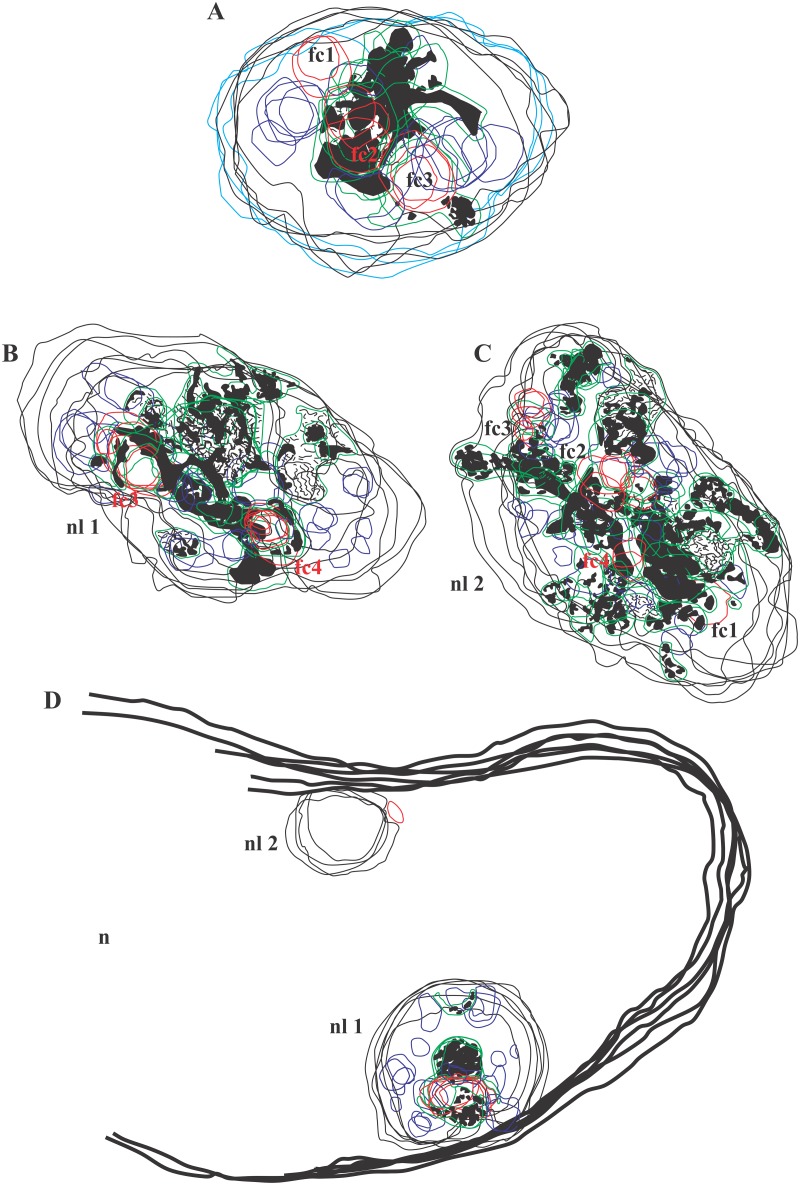
CLEM approach: Step 4.Within cells treated with AMD during 1 h, the contours of nucleolar components identified on serial ultrathin sections were superposed to build 3D models of four different nucleoli (nl). Confocal images of the same nucleoli were used to confirm the identification of ICC (GFP fluorescence) and of FC (UBF fluorescence). The color-code is: nuclear and nucleolar contours—black and light blue lines; FCs—red and brown lines; ICC—black shading; NVs—green lines; DFC—dark blue lines. (A) 3D reconstruction of the equatorial part of the nucleolus in cell N°1(serial ultrathin sections on S10 Fig and serial fluorescent images shown on S14D and S14E Fig). (B, C) Two pre-segregated nucleoli in cell N°2 (serial ultrathin sections on S11 and S12 Figs and serial fluorescent images shown on S14A–S14C Fig). (D) 3D reconstruction of a nucleus with a ring-shaped nucleolus with one FC (serial ultrathin sections on S13 Fig and serial fluorescent images shown on S14F–S14I Fig).